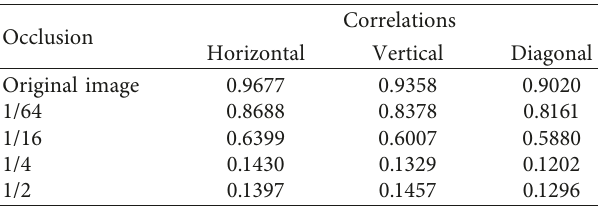
Table 7: Correlations of decrypted images with different intensities of noise